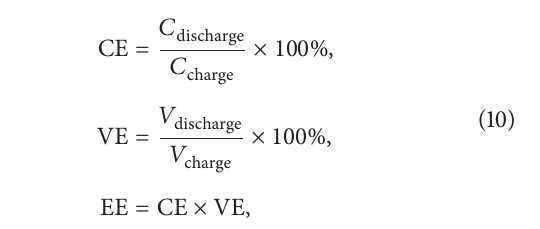
Figure 9: Nyquist plots of the impedance data for N-117 and NM-1H membranes.